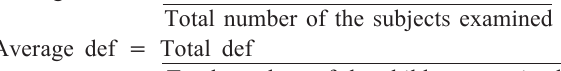
Table 2 - Correlation between blood glucose and salivary glucose in diabetic children and non-diabetic children